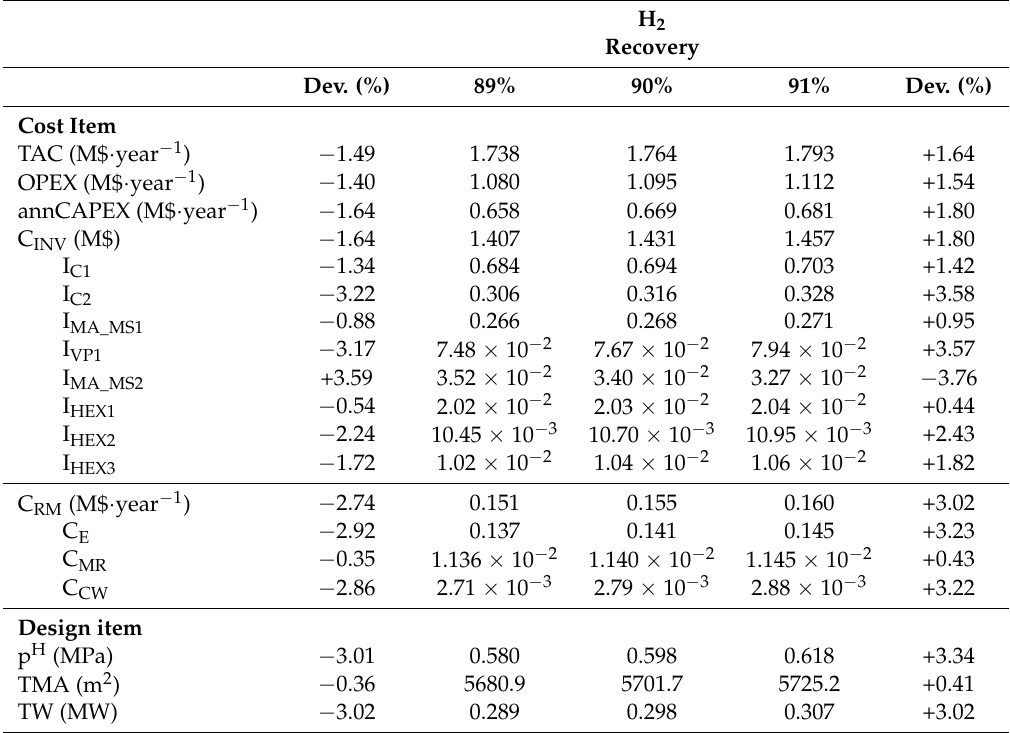
Table 4. Sensitivity of the optimal solution to the H 2 recovery level for a H 2 product purity of 0.90